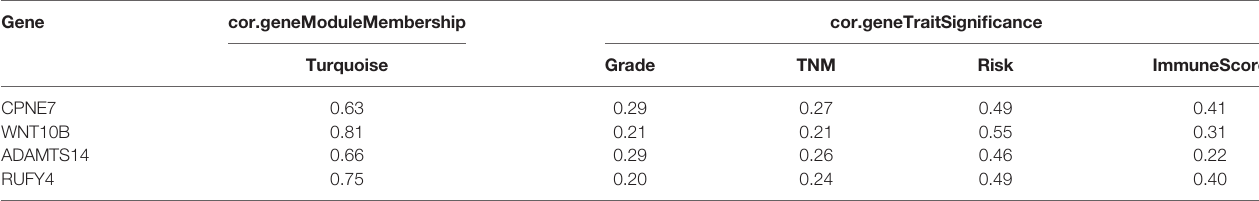
TABLE 1 | Hub genes were identi fi ed via WGCNA.